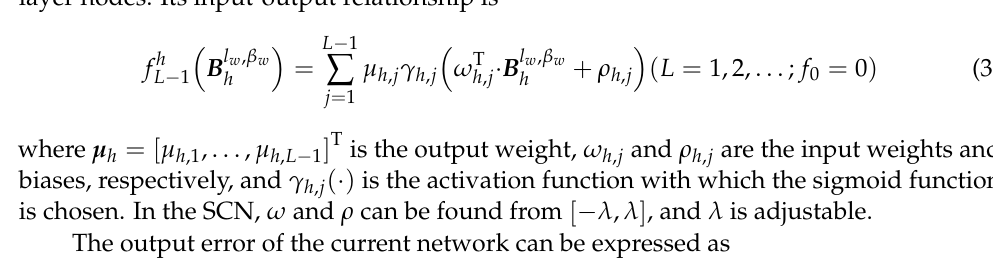
Figure 3. Structure of bagging SCN-based classifier for greengage grading. For the subspace B l w , β w